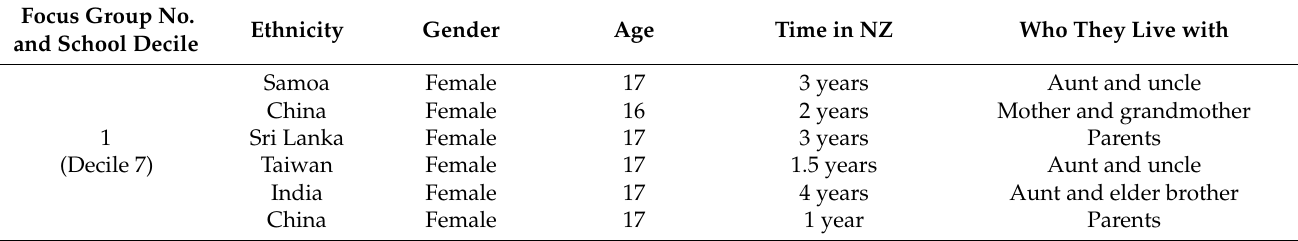
Table 1. Participant demographics across the six focus